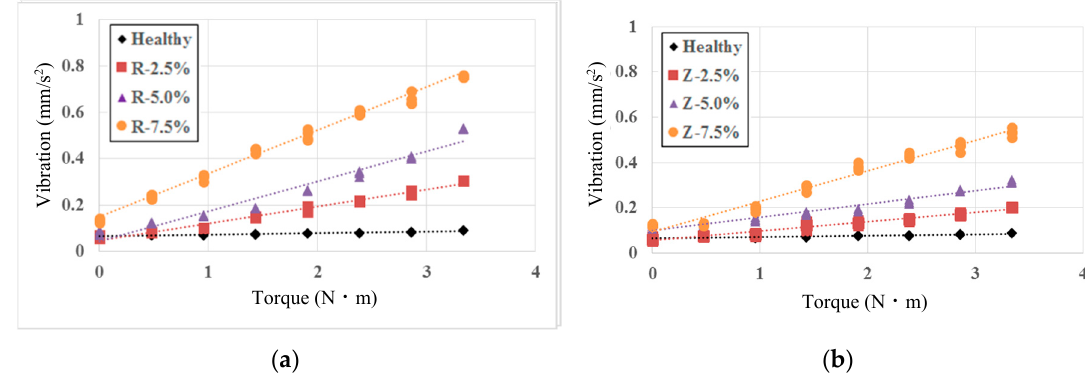
Figure 9. Characteristics of the 12th vibration component relative to load torque: ( a ) radial demagnetization motor; ( b ) axial demagnetization motor.